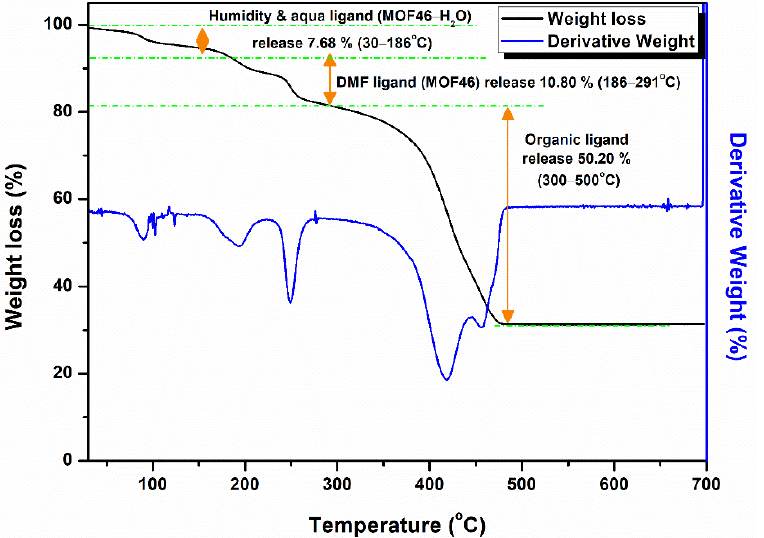
Figure 15. TGA curve of synthesized ZnO@MOF-46(Zn)-DW sonicated for 30 min and left at room temperature for 48 h.